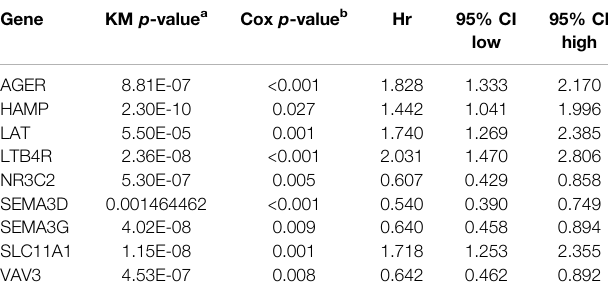
TABLE 1 | OS analysis of nine hub genes with a prognostic value.